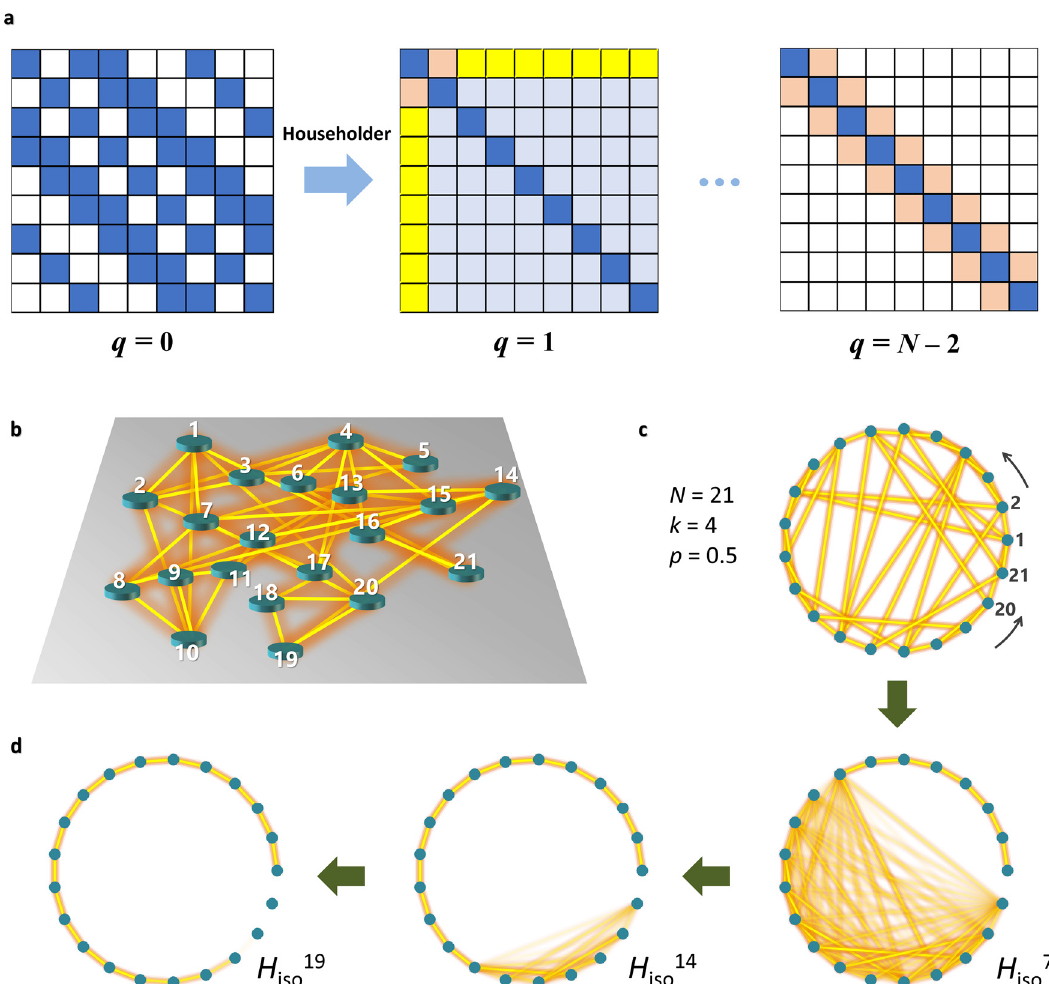
Figure 5: Isospectrality using Householder transformation. (a) A schematic of the Householder-based tridiagonalization for q = 0, q = 1 and q = N − 2. Blue and white boxes represent off-diagonal componentsandzerointhematrices.Reddishboxesdenotethecalculated fi rstoff-diagonalelements.Yellowandlightblueboxesdenotethe removal and alteration of off-diagonal components through each Householder transformation, respectively. (b – d) Householder trans- formation of a complex network to the isospectral 1D system [74]. (b) A schematic of a hypothetical optical network composed of coupled elements (green cylinders for unit elements and yellow lines for inter-elemental interactions, element number N = 21, averaged interaction numberpernode k =4,andrewiringprobabilityfortheWatts – Strogatzprocess p =0.5).(c)Thegraphrepresentationofthestructurein(b).(d) The resulting nearest-neighbor-coupling network through the sequential Householder transformation. Panels (b) – (d) are adapted with permission from [74], ⓒ